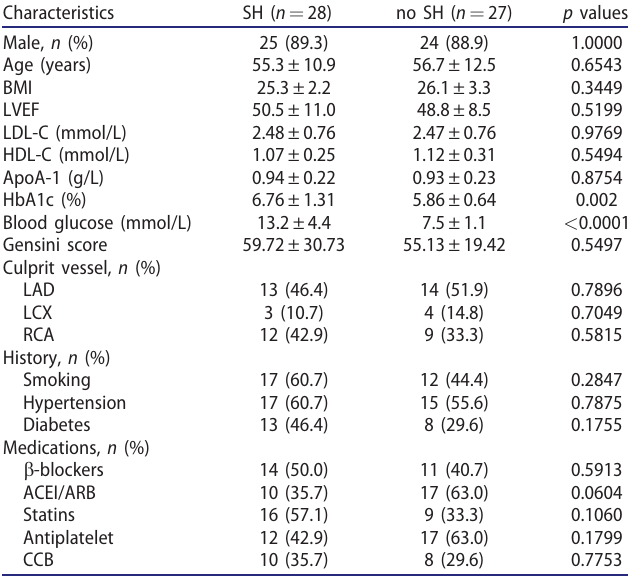
Table 2. Clinical characteristics of patients in the SH and no SH group.